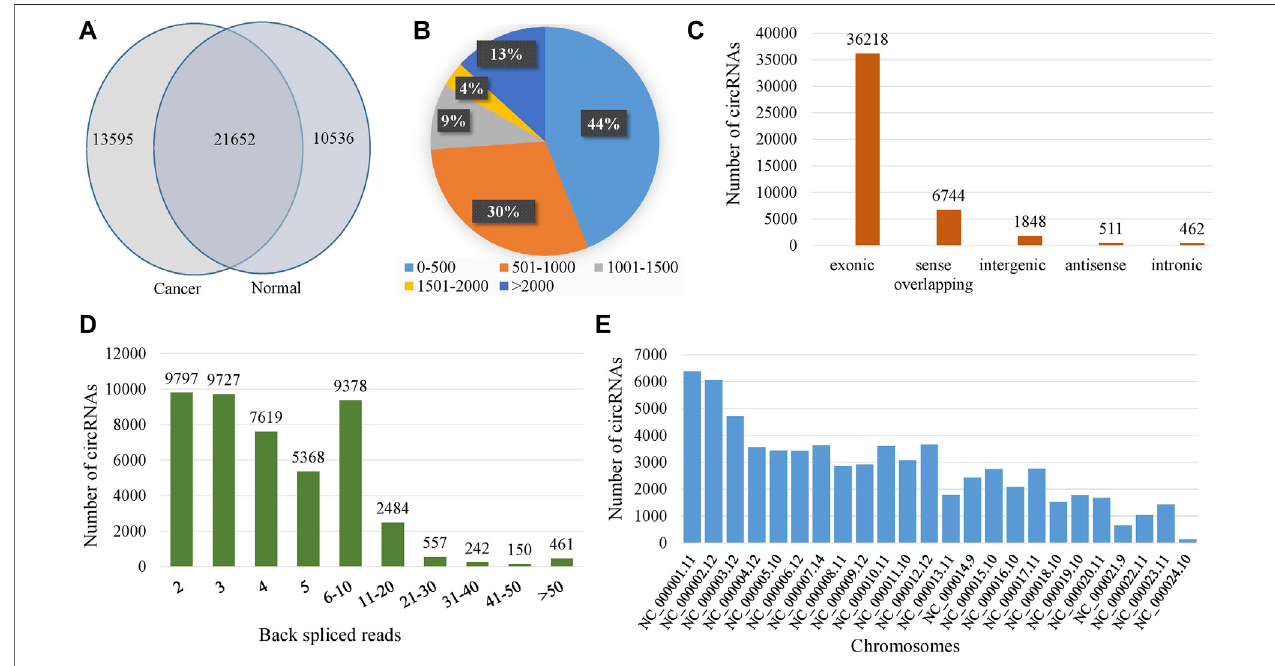
FIGURE 1 | Expression pro fi les of circRNAs. (A) Venn-diagram of the identi fi ed circRNAs in normal and cancer samples, (B) Length distribution of circRNAs, (C) Classi fi cation of the identi fi ed circRNAs, (D) Distribution of the number of back spliced reads, and (E) Chromosome distribution of the identi fi ed circRNAs.